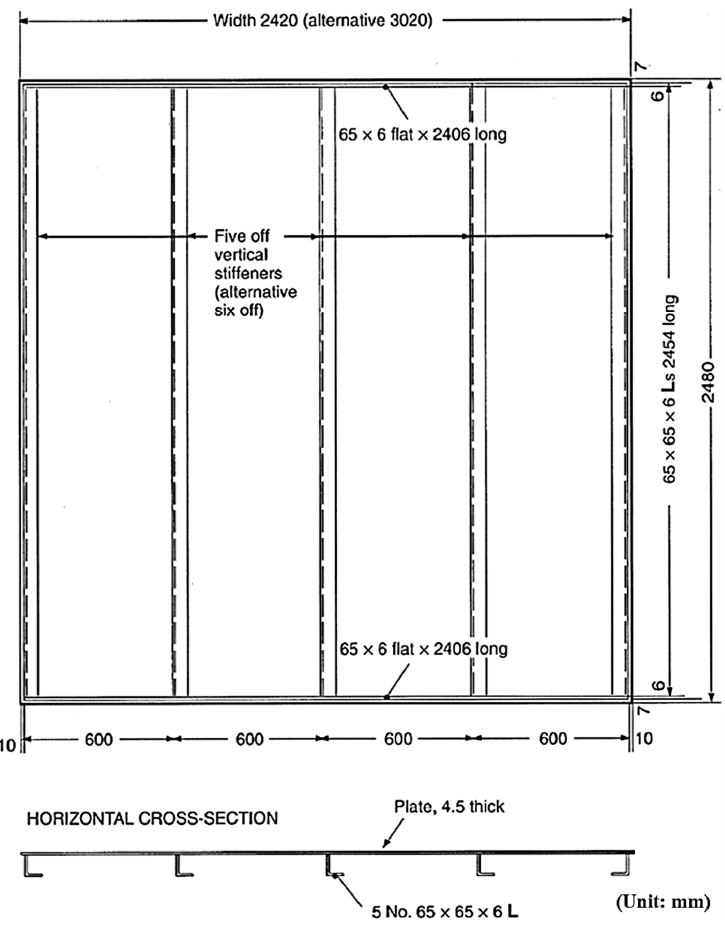
Figure 3. Configuration of the fire test specimen.